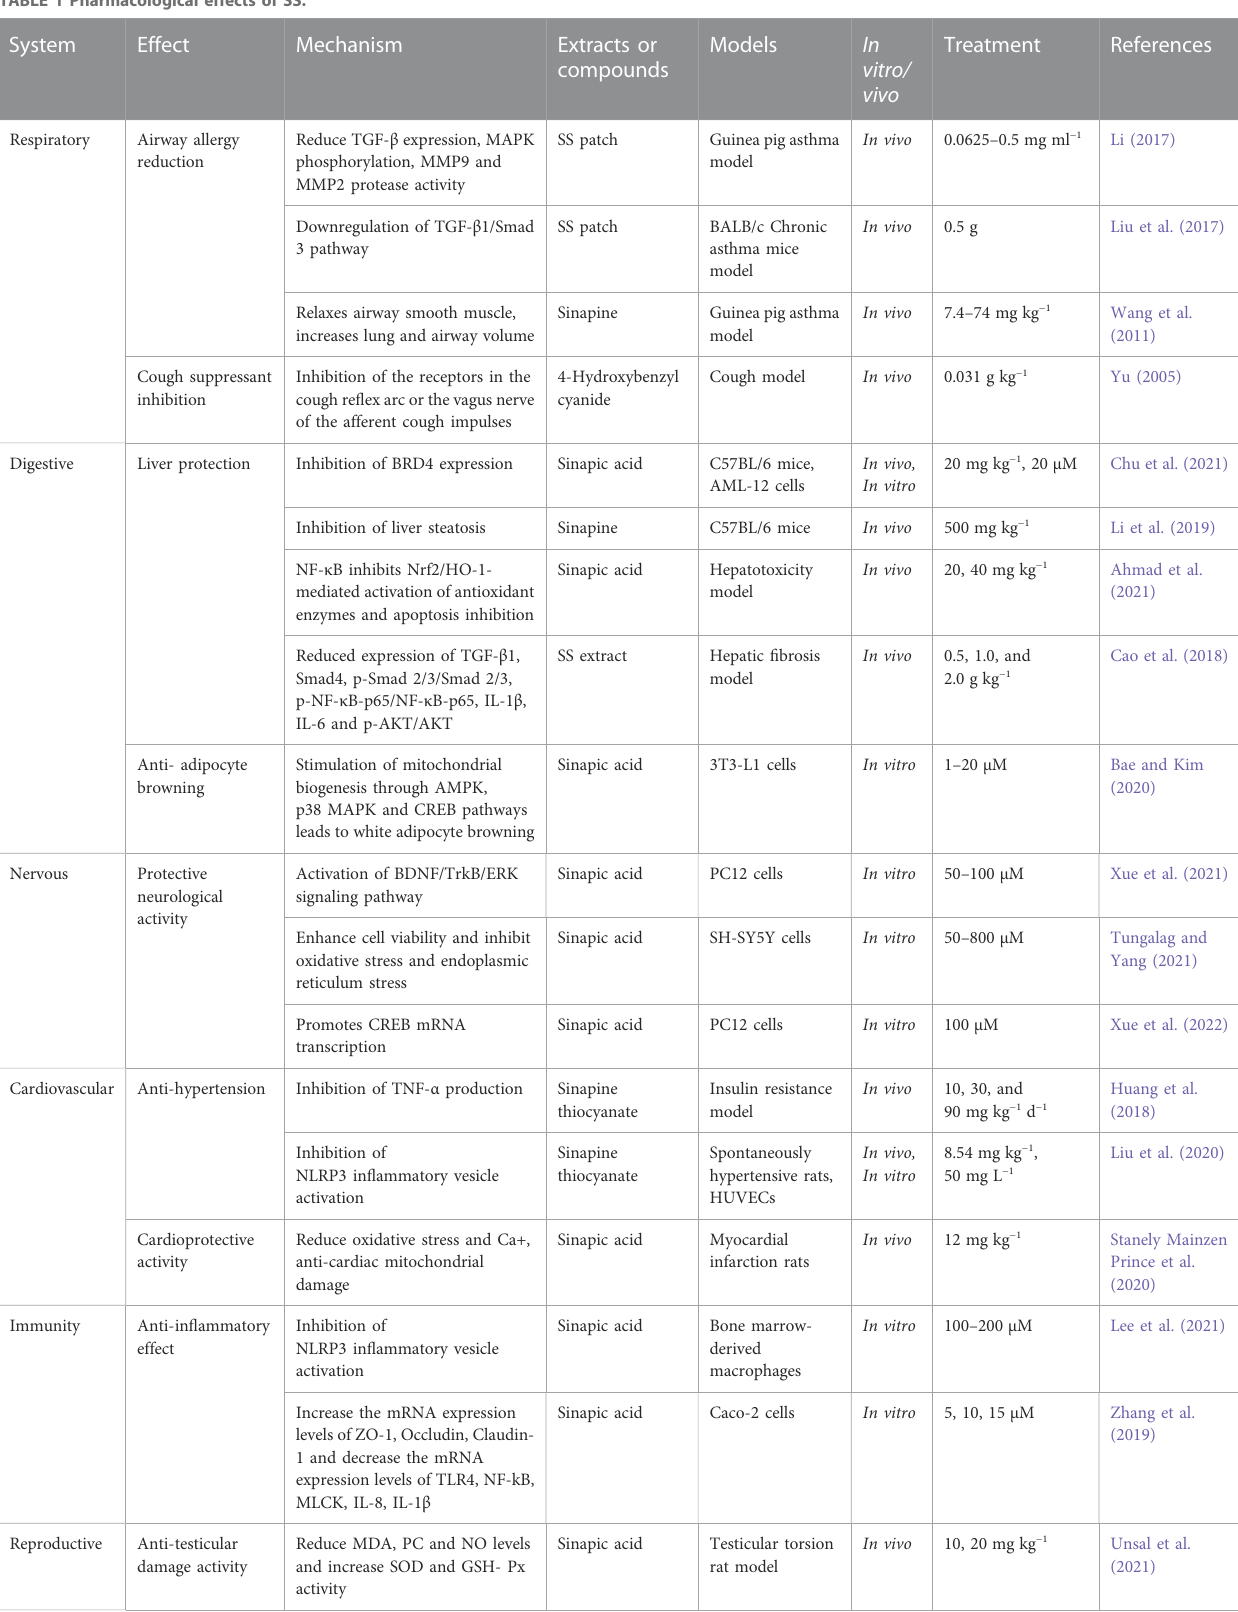
TABLE 1 Pharmacological effects of